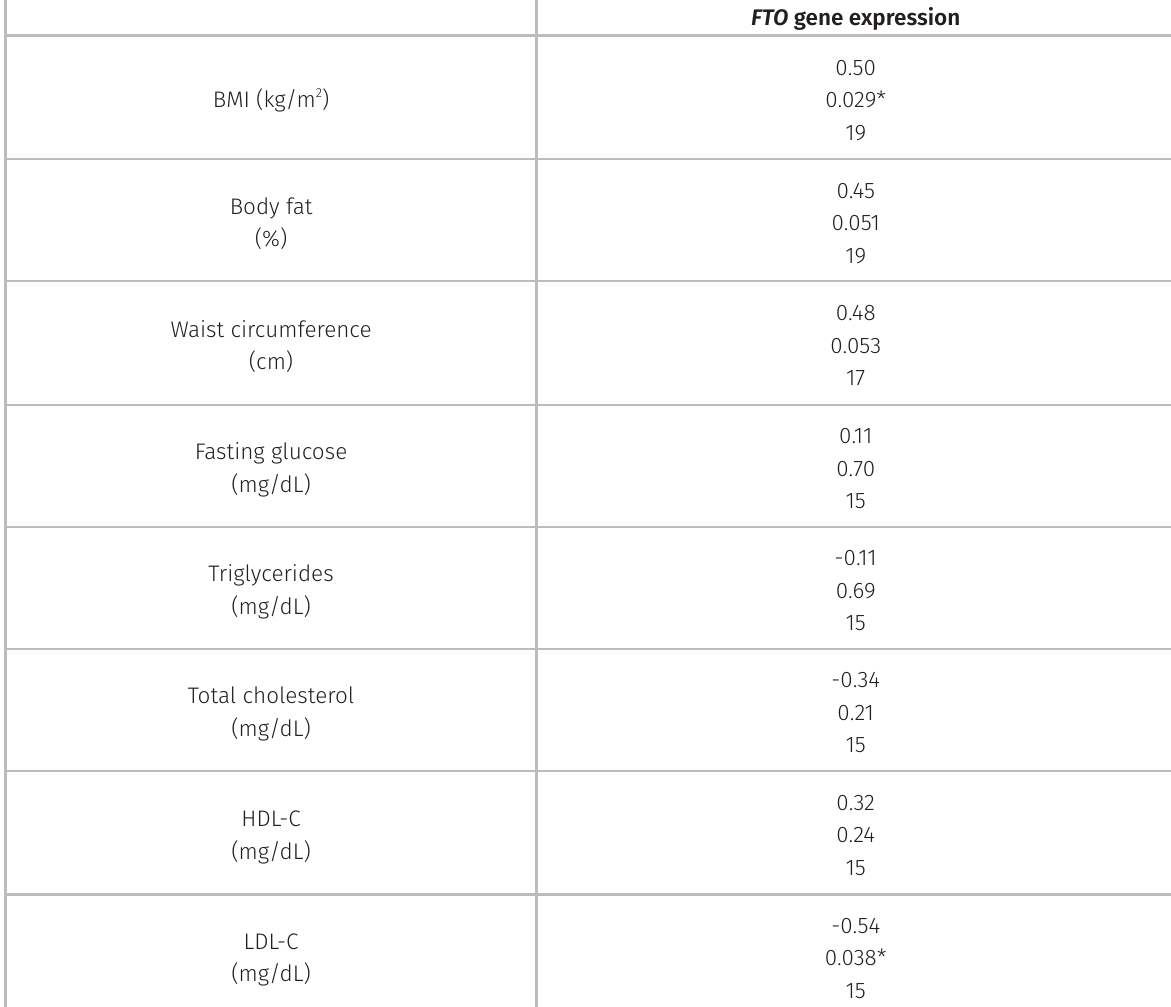
Table II. Pearson’s correlation between FTO gene expression and obesity, glycemia, and lipid